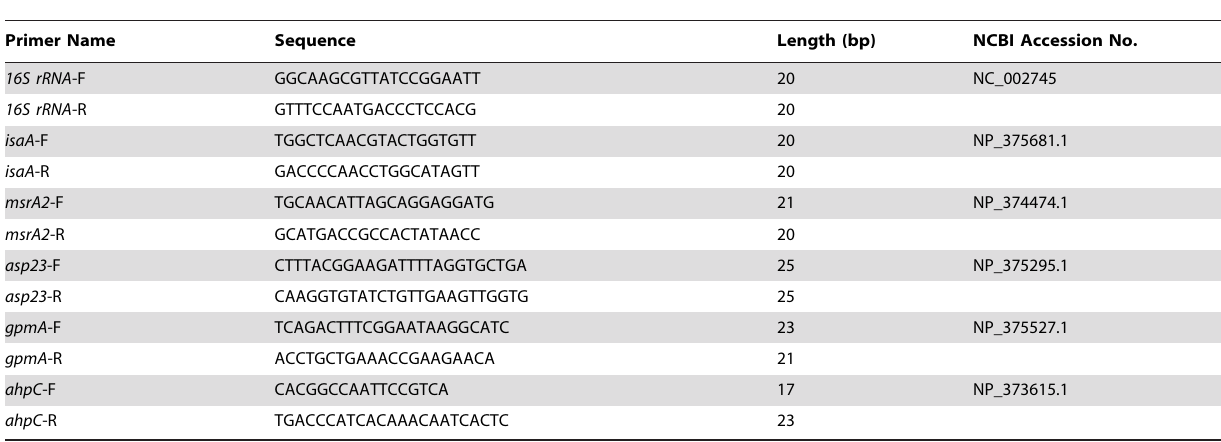
Table 2. List of primers for real-time quantitative reverse transcriptase – PCR.